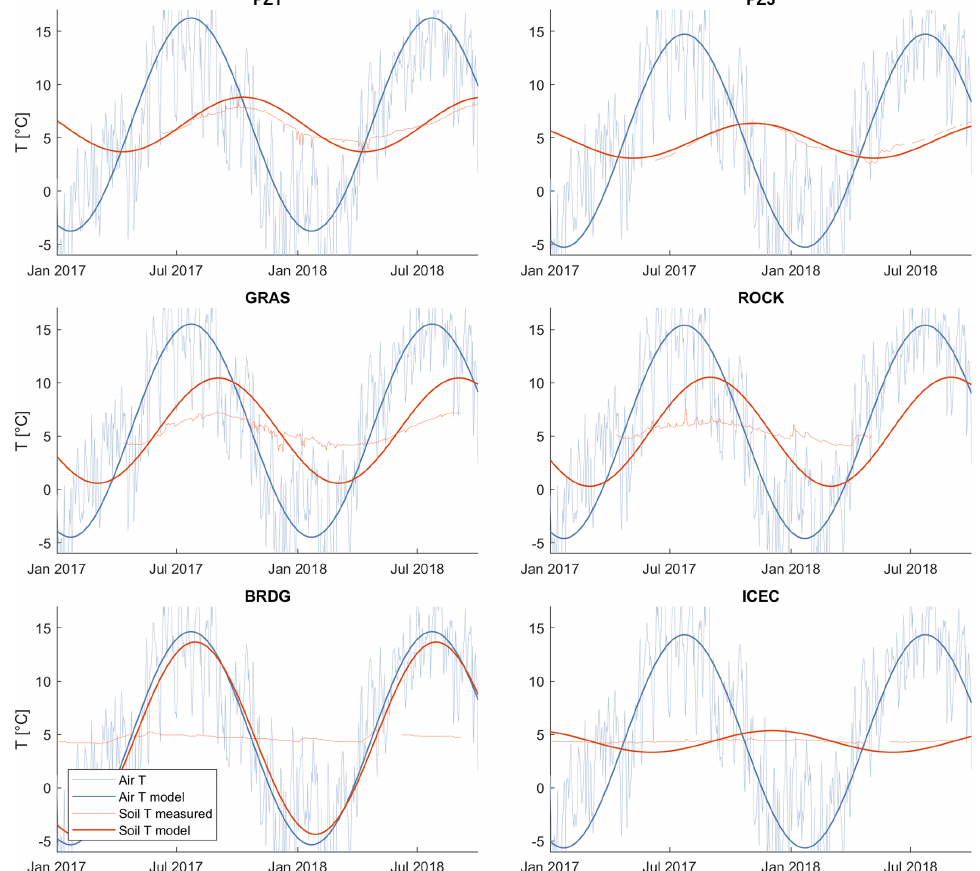
Figure A2. Measured and modeled air and soil temperature for two piezometers (PZ1 and PZ3) and four springs (GRAS, ROCK, BRDG, and